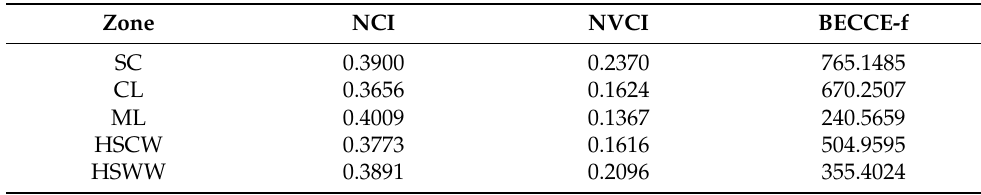
Table 3. The BECCE-f and NCI, NVCI of the 5